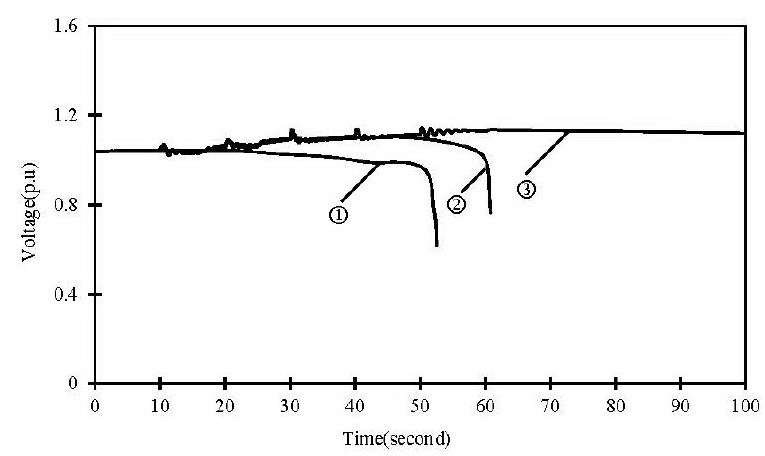
Figure 12. Voltage curve of key bus Hexin.